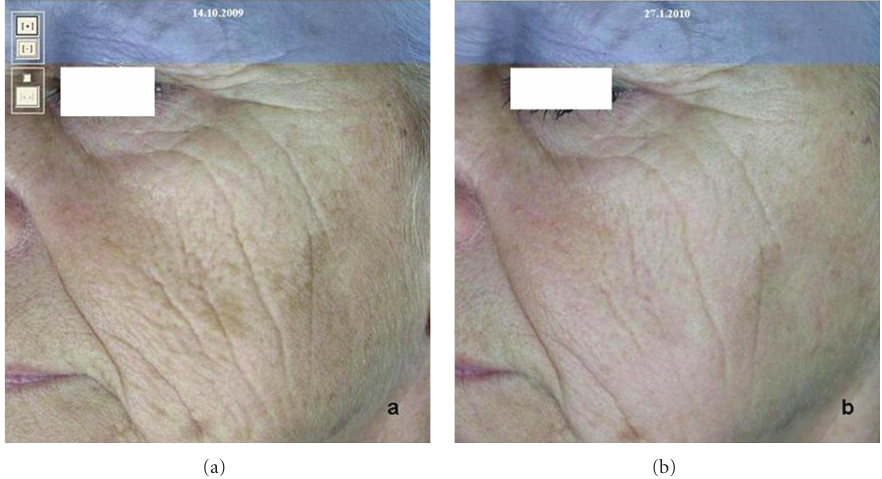
Figure 6: Facial wrinkles at first (a) and after (b) three treatments with fractional microablative CO 2 laser.